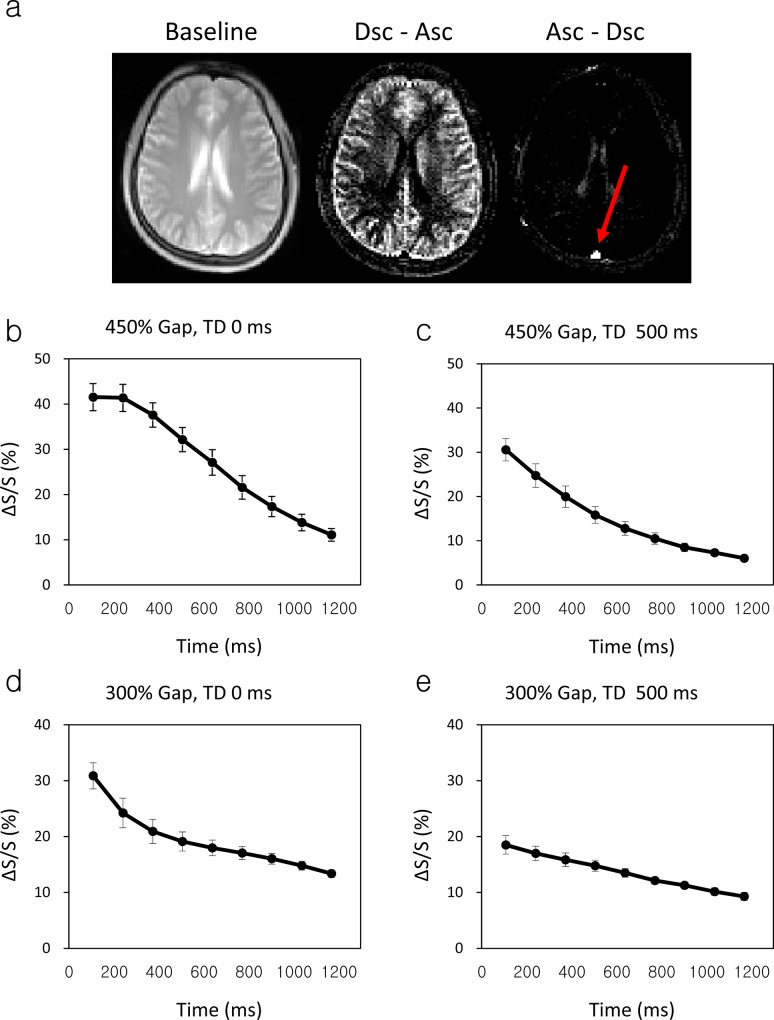
ROI analysis in superior sagittal sinus (SSS).(a) Images of baseline, labeling effects from feet to head (Des − Asc), and labeling effects from head to feet (Asc − Dsc) from a representative slice used for measurement of SSS perfusion signals. (b)−(e) Multiphase signal differences between labeling and control scans in SSS measured from all the 6 subjects for inter-slice gap sizes of 450% (b,c) and 300% (d,e) and inter-slice delay time (TD) of 0 ms (b,d) and 500 ms (c,e). Vertical bars represent the standard deviation across the 6 subjects.